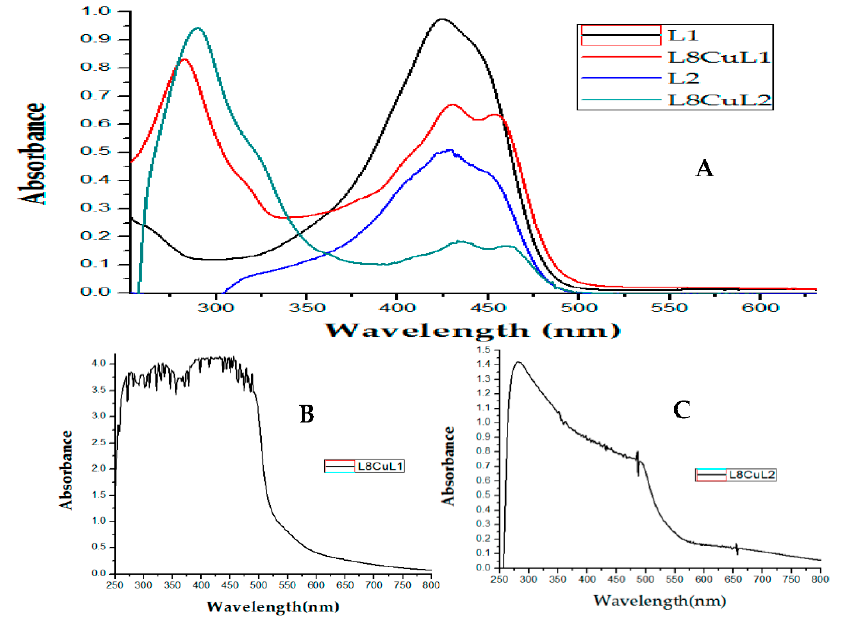
Figure 4. ( A ) Electronic absorption spectra of L1 (15 µM), L2 (15 µM), D8CuL1 (15 µM) and D8CuL2 (15 µM); ( B ) d-d transitions for D8CuL1 (2 mM); ( C ) d-d transitions for D8CuL2 (2 mM). Table 1. UV-vis spectral band assignments and molar extinction coefficient ( ε ) of ligands and copper complexes.